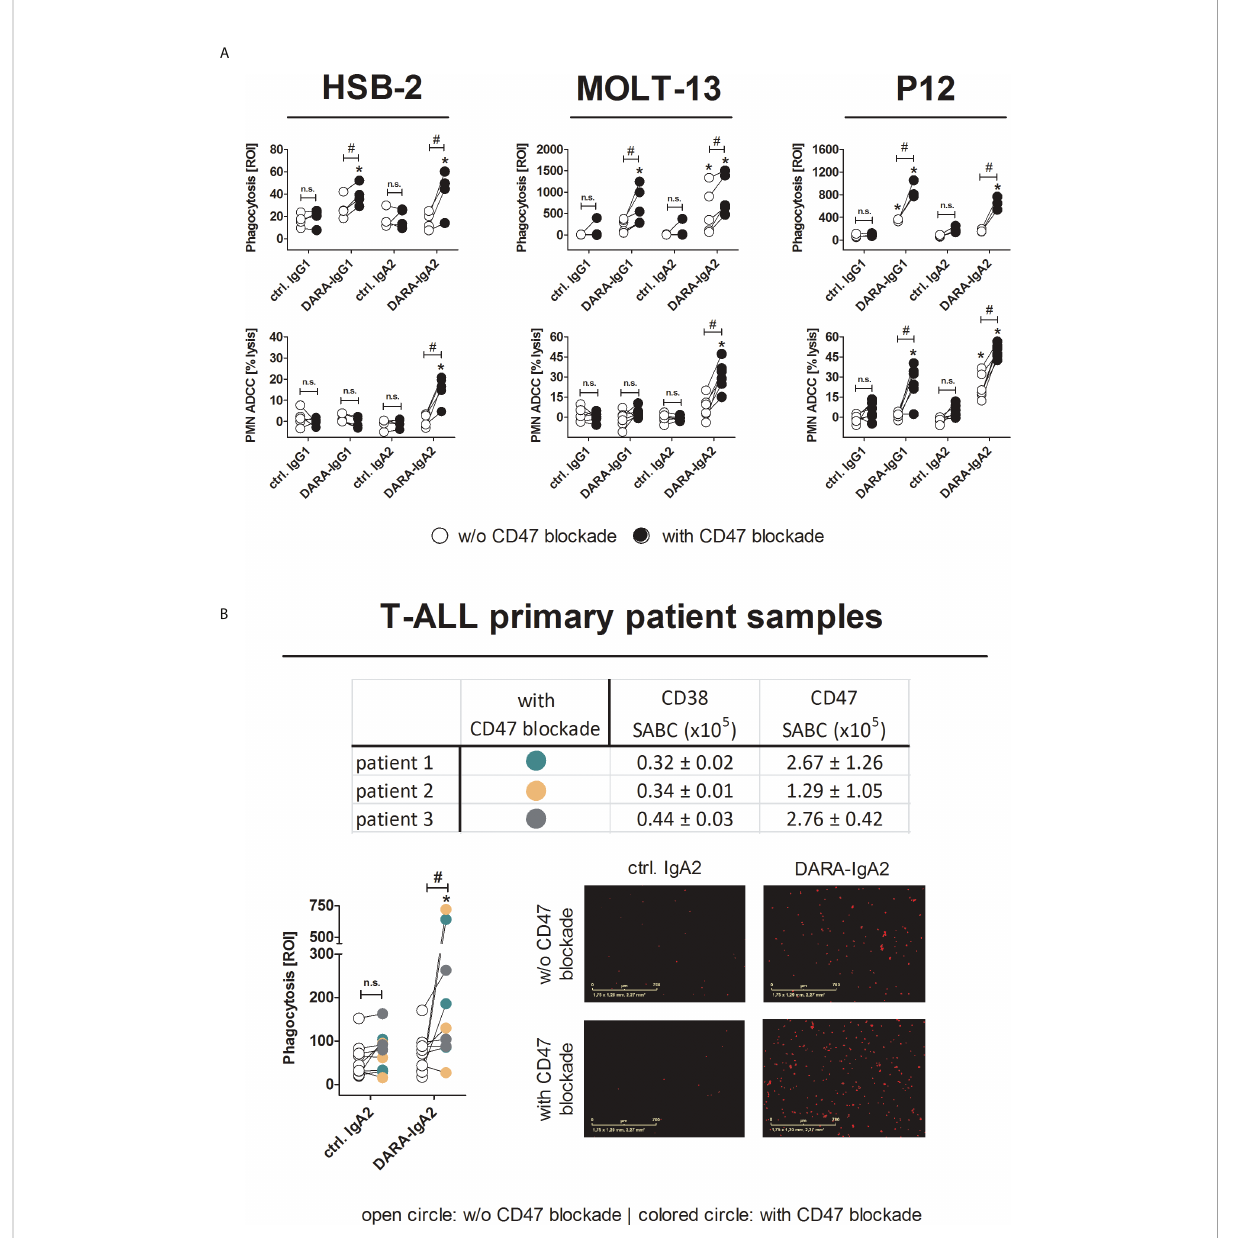
FIGURE 3 Blocking CD47/SIRP a interactions leads to ef fi cient myeloid cell-mediated killing of T-ALL cell lines and patient samples by DARA-IgA2. (A) HSB-2, MOLT-13 and P12 cell lines were used as targets in ADCP (upper panel) and PMN-mediated ADCC (lower panel) assays in the absence (white circles) or presence (black circles) of the CD47 blocking antibody 5F9-IgG2 s (20 µg/ml). DARA and isotype controls were used at 10 µg/ml. For ADCP, an E:T ratio of 1:1 was applied while in ADCC assays the E:T ratio was 80:1. M0 macrophages were generated using 50 ng/ml M-CSF, PMN were activated with GM-CSF (50 U/ml). Values of at least three replicates using different donor effector cells are presented. * indicates signi fi cant differences between DARA and the respective isotype control (p < 0.05 by two-way ANOVA), # depicts signi fi cant differences between with and without CD47 blockade (p < 0.05 by two-way ANOVA). (B) T-ALL patient samples (n=3) were tested for expression of CD38 and CD47. Speci fi c antigen-binding sites per cell (SABC) were quanti fi ed by CD38 antibody HB-7 and CD47 antibody B6H12 at saturating concentrations (5 µg/ml). FITC-conjugated anti-mouse IgG F(ab ’ ) 2 fragments were used for detection. Mean values ± SEM of three replicates are indicated in the table. ADCP assays (lower left panel) were performed in the absence or presence of the CD47 blocking antibody 5F9-IgG2 s (20 µg/ml). Patients were illustrated by different colors (color code included in table). DARA-IgA2 and isotype control were used at 10 µg/ml. An E:T cell ratio of 1:1 was applied. Shown are the red object counts per image (ROI) at maximal phagocytosis with macrophages from three different donors. Microscopic images (magni fi cation 10x) show phagocytosed T-ALL patient cells (red dots) at the time of the highest phagocytosis rate. * indicates signi fi cant differences between DARA-IgA2 and isotype control (p < 0.05 by Wilcoxon matched-pairs signed rank test), # depicts signi fi cant differences between with and without CD47 blockade (p < 0.05 by Wilcoxon matched-pairs signed rank test. n. s., not signi fi